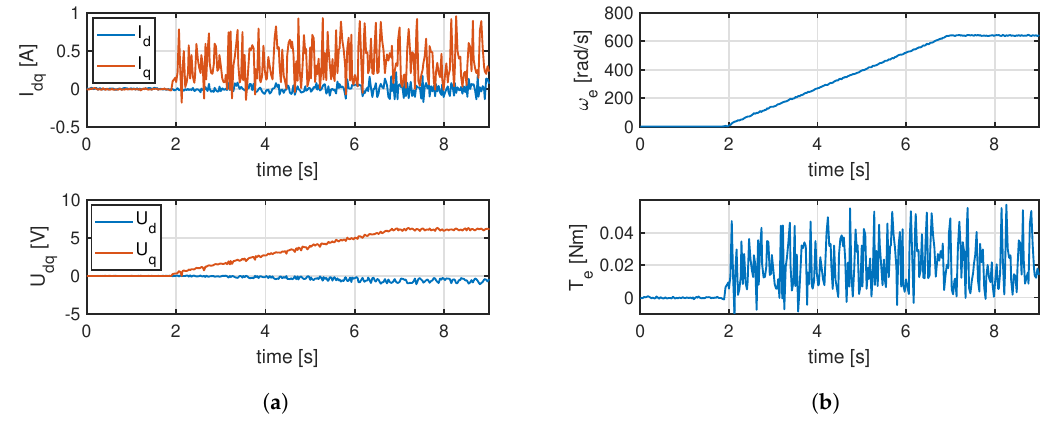
Figure 21. ( a ) dq currents and voltages; ( b ) ω e and T e during start-up sequence of Figure 20. Figure 22 shows acoustic noise at steady-state case at ω e = 300 rad 2nd and 6th harmonic of cogging torque map into q -axis current and turning on CHC